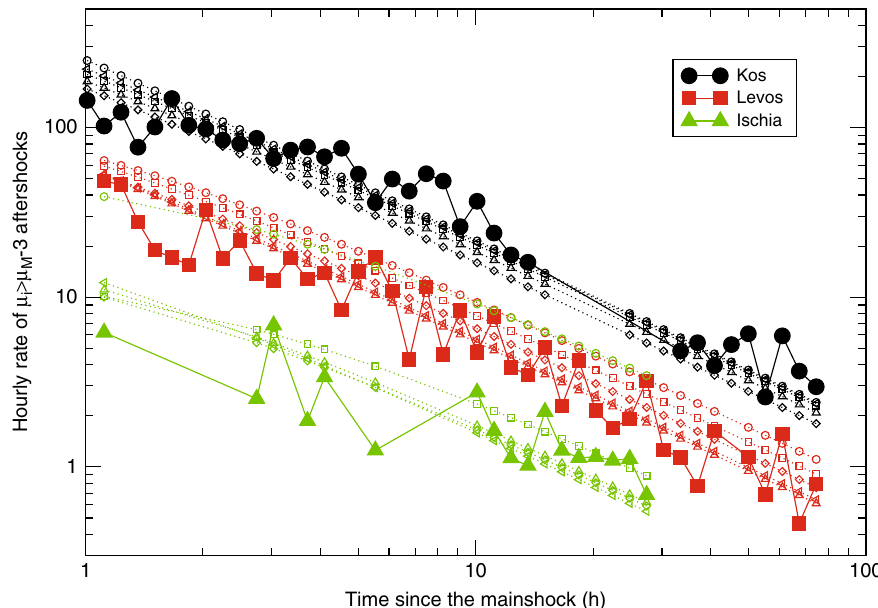
Fig. 5 Test of the method for the Kos, Lesvos, and Ischia earthquakes. We use fi lled large symbols for the hourly rate λ ( t ) of aftershocks with μ i > μ M − 3 with different symbols and colors for different mainshocks (see legend). Small empty symbols are used for the predicted aftershock rate obtained using in the OU law Eq. (1) the values of K and c provided by our model. Different colors correspond to different mainshocks whereas different symbols (circles, squares, diamonds, triangles up, triangles left) correspond to different learning periods ( T = 1/6, 1/4, 1/2, 1, and 6 h),